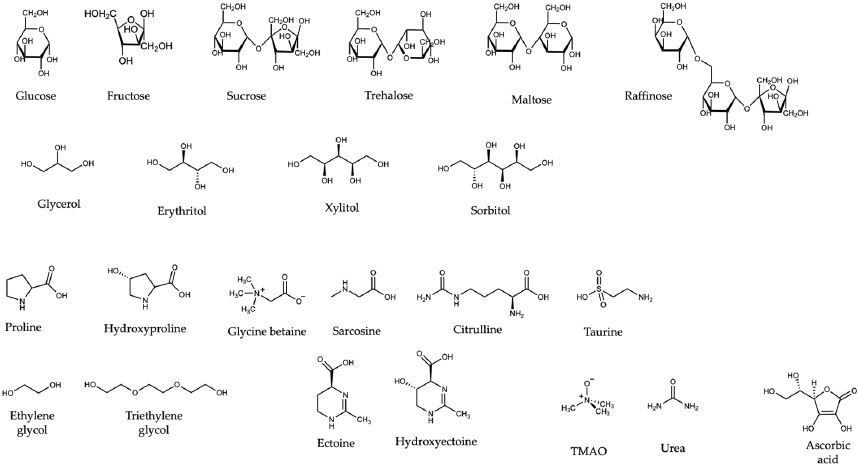
Figure 2. Structures of osmolytes and small molecules referenced in this Review.